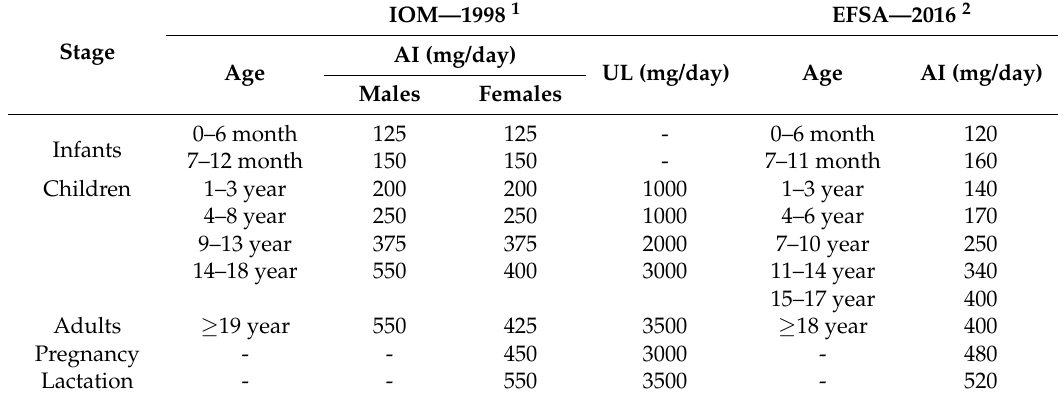
Table 3. Current adequate intake recommendations for